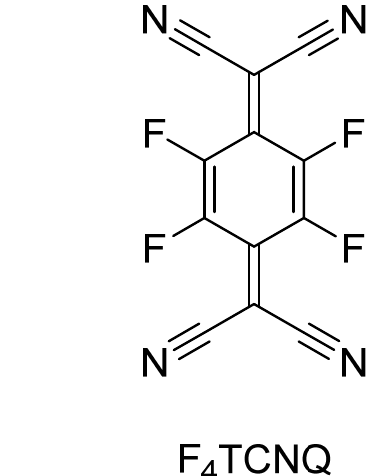
Figure 2. The commonly used organic electron-acceptors TCNQ ( left ) and F 4 TCNQ ( right ).